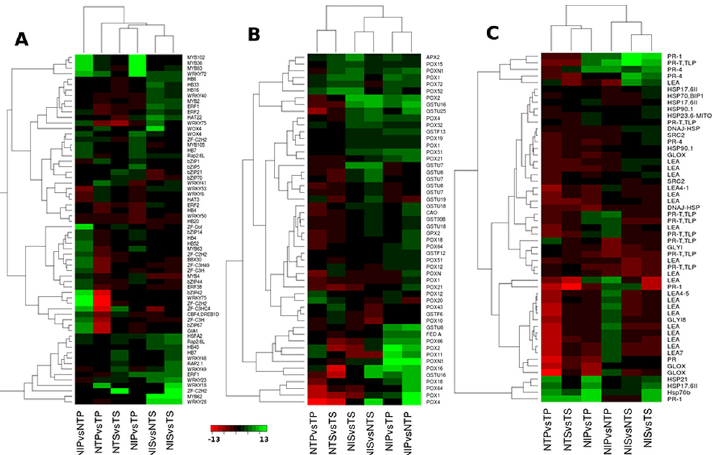
represents down-regulated (log2FC (cid:3) 2) genes. For gene names represented in the heatmaps please refer to the S1 Table